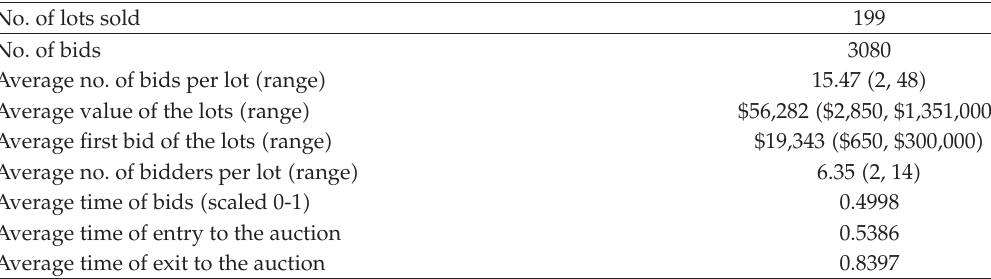
Table 1: Data description.